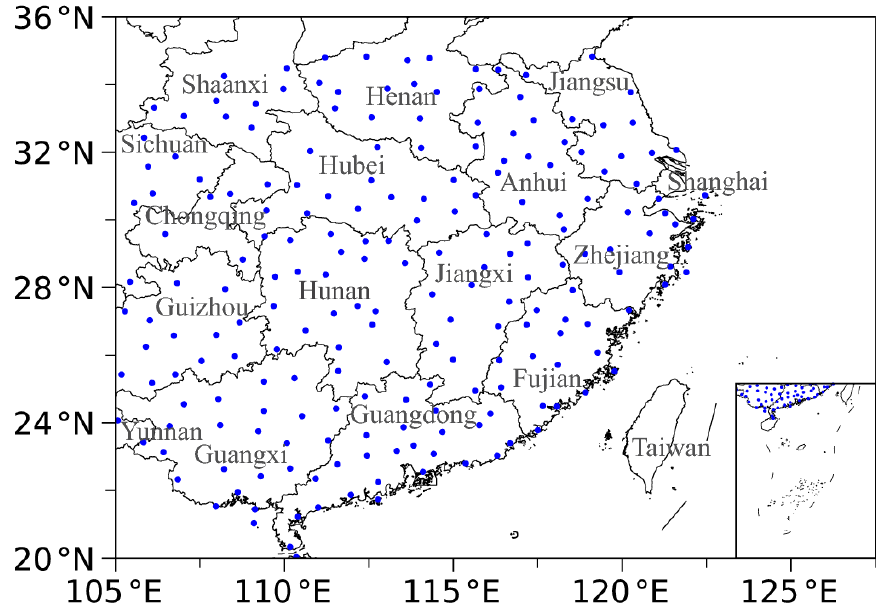
Figure 1. 206 observation stations in southern China.